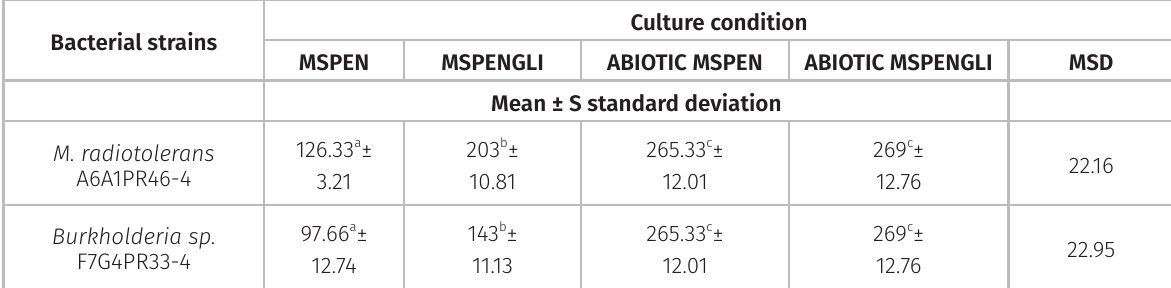
Table I. Concentration of Pendimethalin (mg/ml) following incubation with the bacteria strains in two mineral salt mediums and abiotic degradation controls after 30 days of